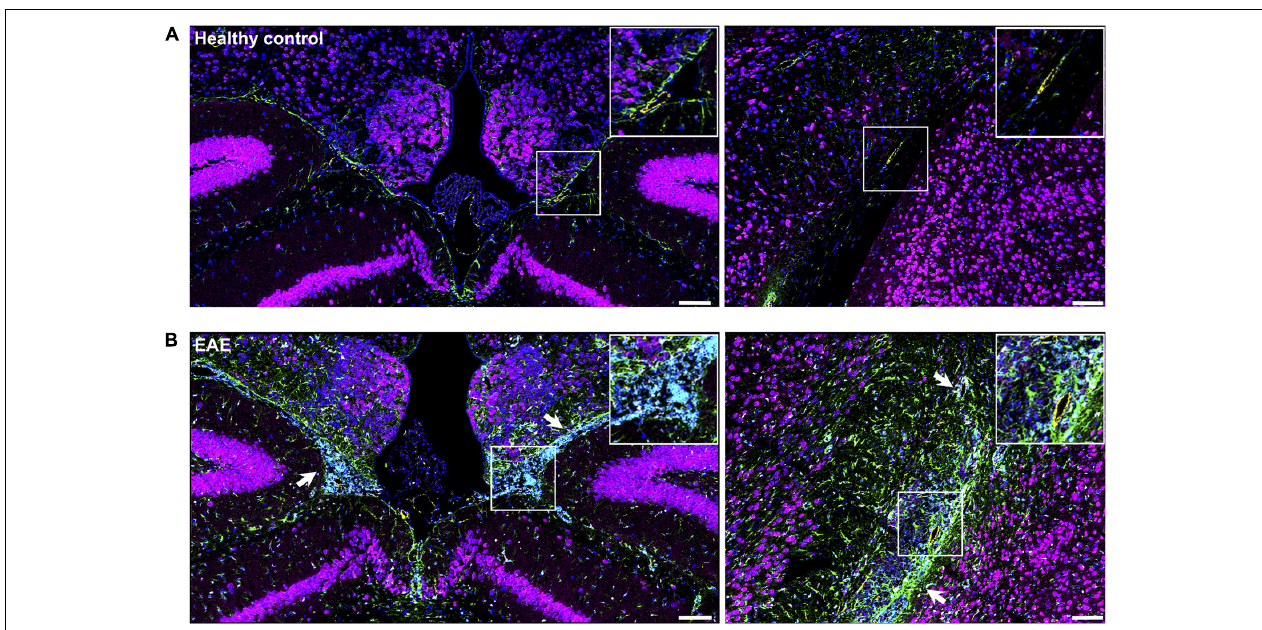
FIGURE 8 | Visualization of brain inflammation induced by EAE using IMC. (A) Brain section of a healthy control (naïve) mouse at the third ventricles (left) and brain stem and hippocampal formation (right). (B) Extensive inflammation during EAE can be visualized by infiltration of CD45 + cells (cyan), astrogliosis (GFAP, green) and activated microglia (Iba-1, white) (white arrows). Neurons (NeuN—magenta), astrocytes (GFAP—green), endothelial cells (CD31—yellow), nuclei (histone H3—blue), microglia (Iba-1—white), leucocytes (CD45—cyan). Scale bar: 100 µ